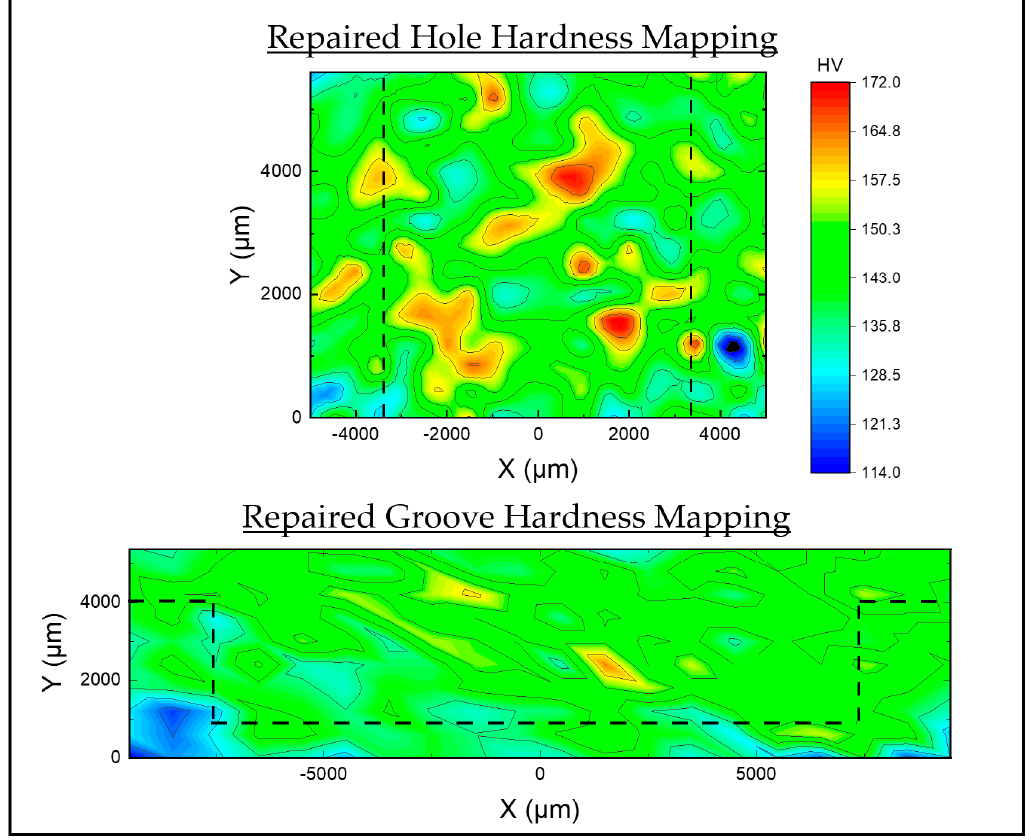
Figure 8. Hardness mapping of the ( top ) repaired hole and ( bottom ) repaired groove samples. The dashed lines represent the original perimeters of the hole and groove, respectively.